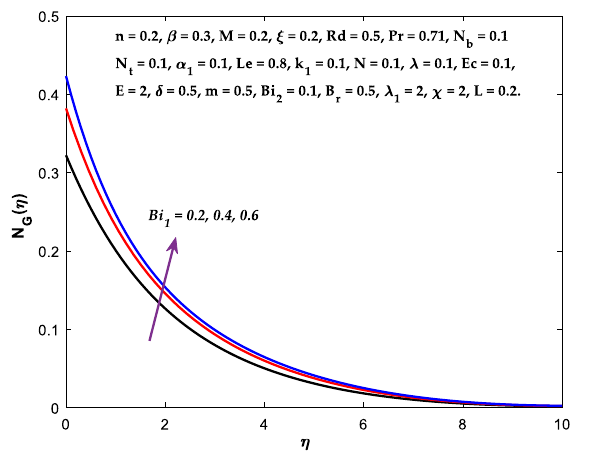
Figure 25. Diagram of Bi 1 v/s N G (η) .